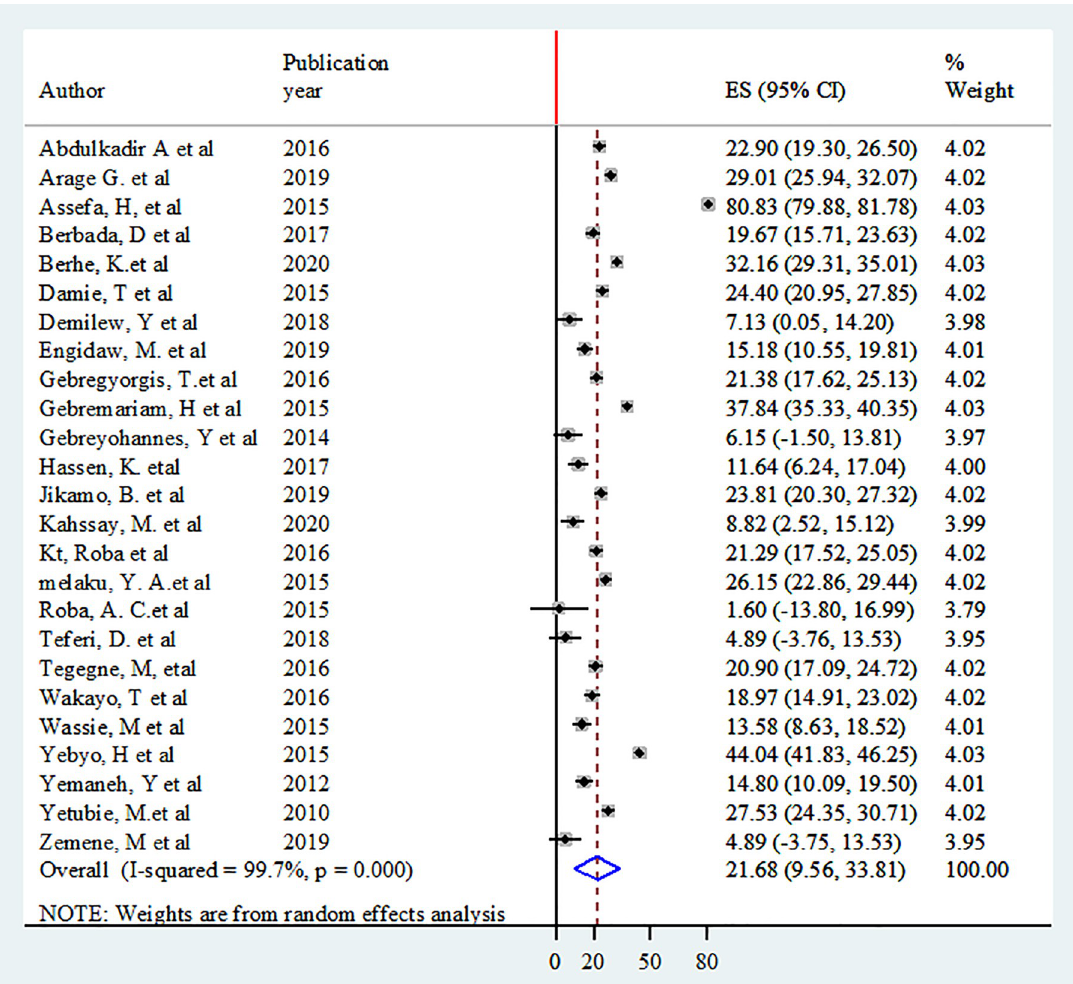
Fig 4. Forest plot of the pooled prevalence of adolescent thinness in